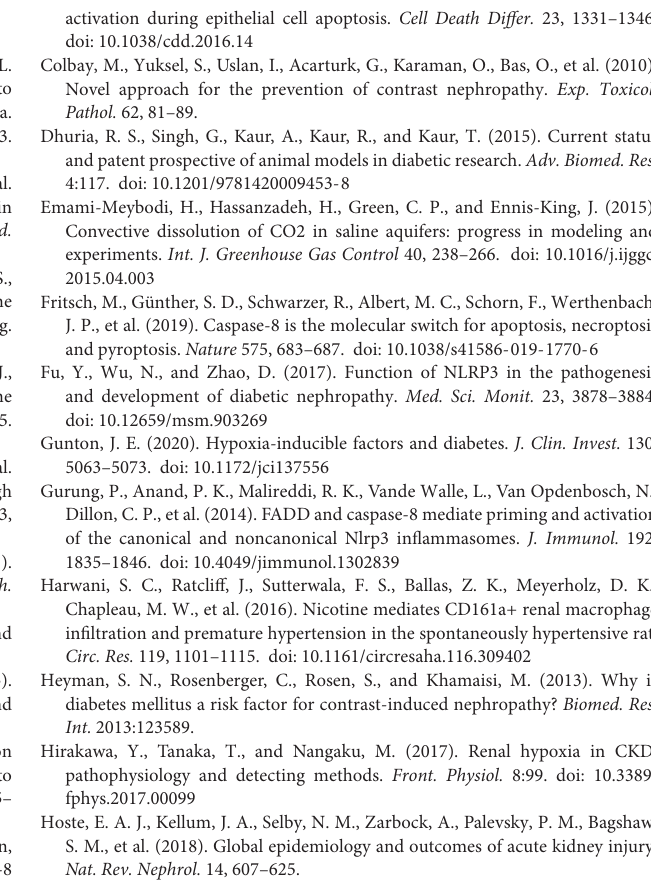
Supplementary Figure 2 | Blood glucose changes. After intraperitoneal injection of STZ, blood glucose of DM model got an extreme increasing ( ∗∗∗ P < 0.0001, # P > 0.05). DM, diabetes mellitus. Supplementary Figure 3 | Kidney weight. Kidneys of DM rats are heavier than healthy rats ( ∗∗∗ P < 0.0001). DM, diabetes mellitus. Supplementary Figure 4 | uMA urine microalbumin. 1, ≤ 10 mg/L; 2, > 30 mg/L; 3, > 80 mg/L; 4, ≥ 100 mg/L ( ∗ P < 0.05, ∗∗ P < 0.005). Supplementary Figure 5 | CD3 and Ly6G expression in kidney after injection for 48 h × 400. (A) CD3, which represents T cell marker; (B) Ly6G, which represents phagocyte marker. Supplementary Table 1 | Composition of high hat and sugar